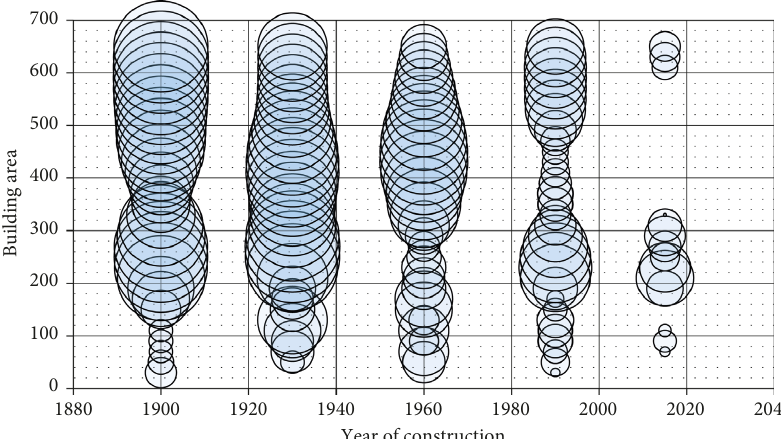
Figure 15: Sensitivity analysis results: U-opaque value for all variables. The relative bubble size is the U-opaque value.